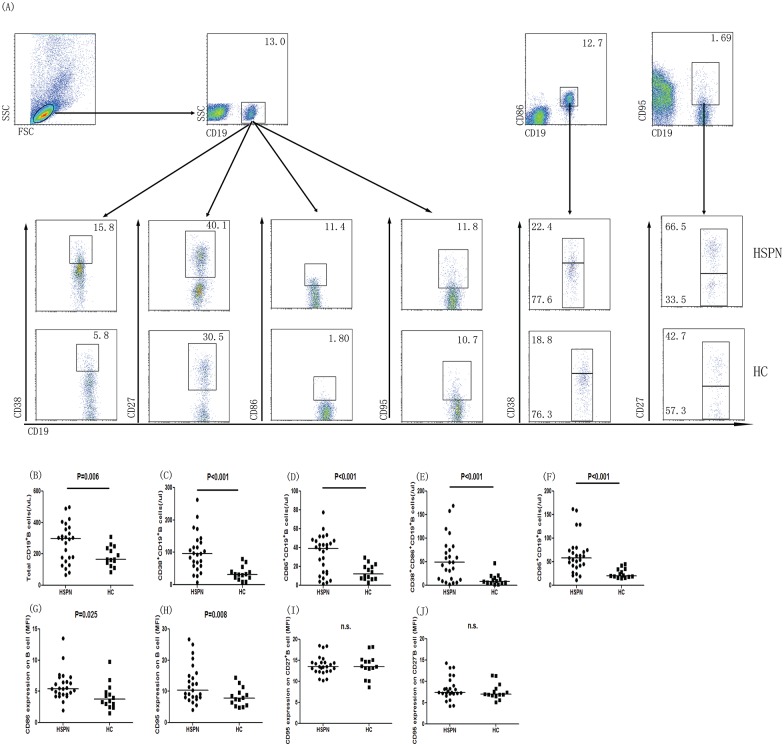
Flow cytometric analysis of the numbers of different subsets of B cells.PBMCs were collected from HSPN patients and healthy controls. Then, they were stained with PerCP-anti-CD19, PE-anti-CD38, APC-anti-CD86, or PerCP-anti-CD19, PE-anti-CD27, and APC-anti-CD95 (Biolegend, San Diego, CA, USA), or isotype-matched control IgG (Beckton Dickinson, San Jose, CA, USA). For further analysis of different subsets of B cells, the cells were gated initially on living lymphocytes and then on CD19+ B cells. (A) Flow cytometric analysis results. (B) The numbers of CD19+ B cells. (C) The numbers of CD38+CD19+ plasma cells. (D) The numbers of CD86+CD19+ B cells. (E) The numbers of CD38+CD86+CD19+ B cells. (F)The numbers of CD95+CD19+ B cells. Data are expressed as the means for individual subjects included in two separate experiments. (G) Mean fluorescence intensity of CD86 on B cells. (H) Mean fluorescence intensity of CD95 on B cells. (I) Mean fluorescence intensity of CD95 on CD27+ B cell subsets. (J) Mean fluorescence intensity of CD95 on CD27- B cell subsets. The horizontal lines represent the median values. Data were analyzed by Mann-Whitney U-test.